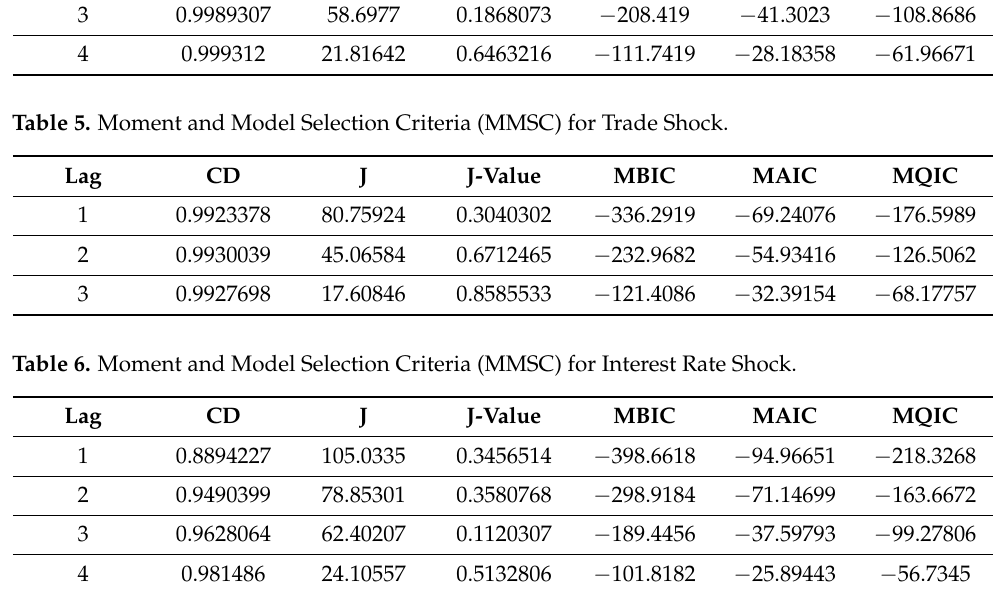
Table 7. Generalised Method of Moments (GMM) Panel Vector Autoregression Model for GDP Shock. Response to